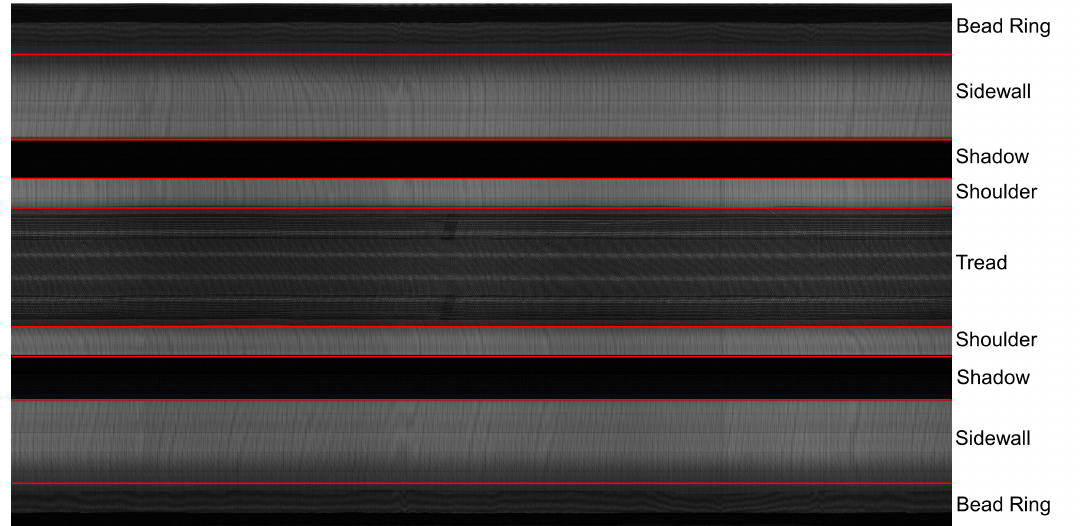
Figure 2. A horizontally displayed entire defect-free X-ray image, divided into five areas: bead ring, sidewall, shadow, shoulder and